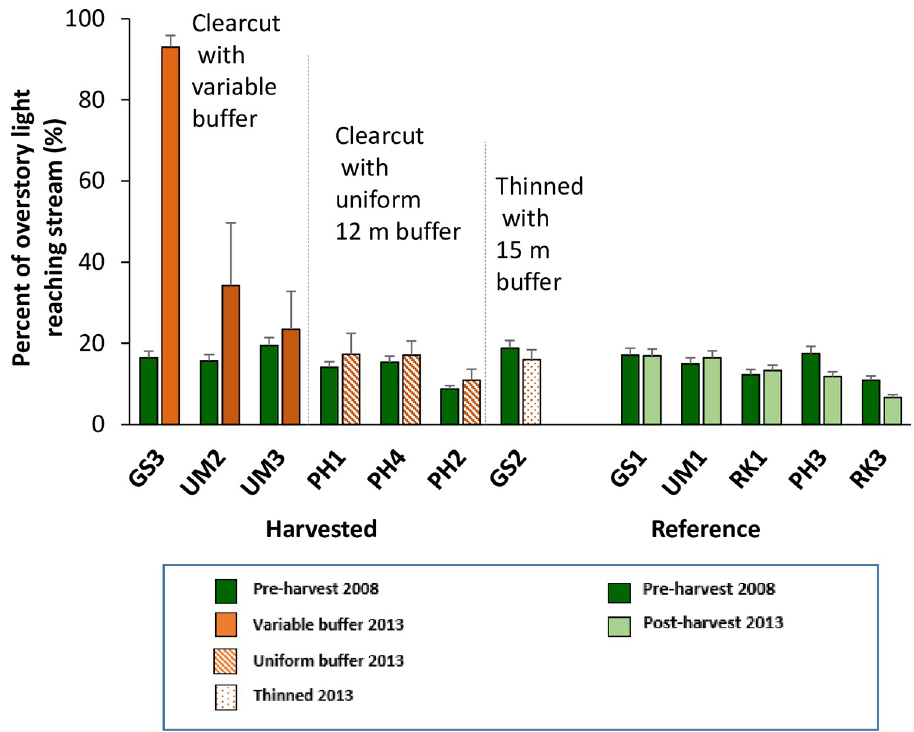
Fig 2. Percent of light reaching streams pre- and post-harvest. The percent of overstory light reaching the streams, measured using hemispherical photos in 2008, pre-harvest, and in 2013, post-harvest. Sites are organized from left to right by percentage of overstory light reaching the stream post-harvest. Bars show site averages and standard